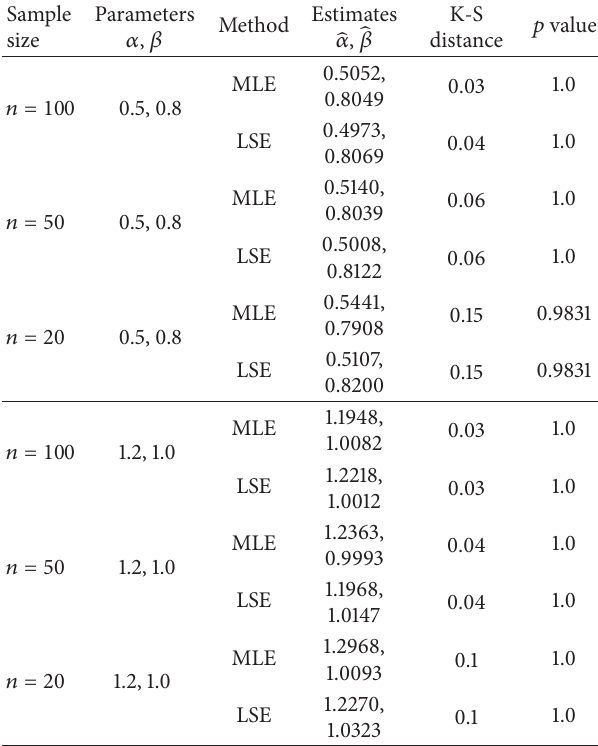
Table 1: Parameter